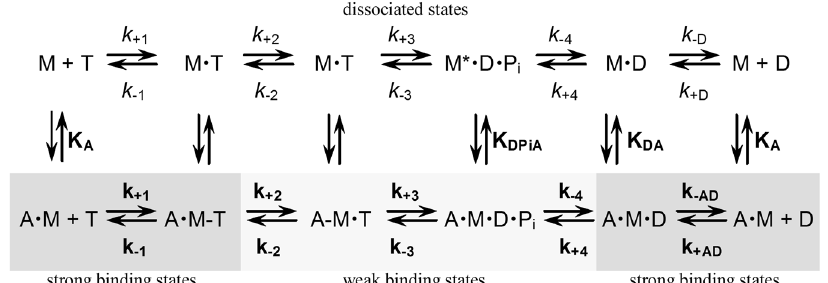
Figure 3. Interaction scheme for actin and nucleotide binding of myosin. A refers to actin, M to myosin, T to ATP, D to ADP and Pi to inorganic phosphate. The asterisk ( * ) indicates the increased fluorescence of W501 induced by ATP hydrolysis. For the equilibrium binding constants a notation is used that distinguishes between constants in the absence and presence of actin by using italics type ( k x , K x ) and bold ( k x , K x ), respectively.